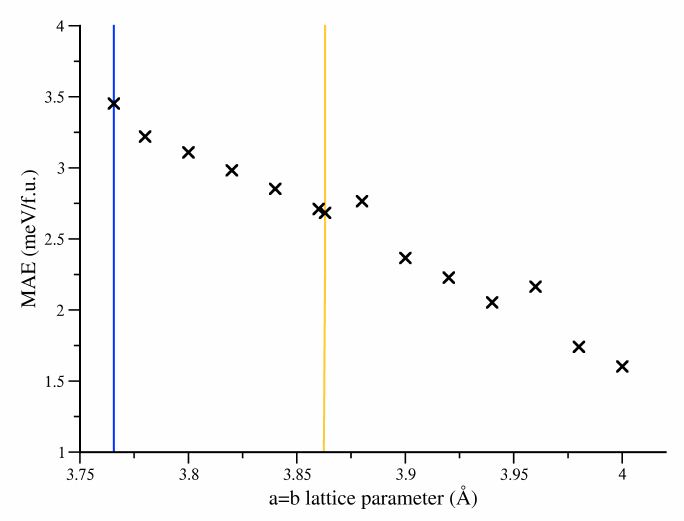
Figure 7. Change of energy difference between (cid:126) c - and (cid:126) a -aligned spin structures with strain for FePt. This figure includes both the LDA (blue line) and LDA+U (yellow line) structures at their exact in-plane lattice parameter.